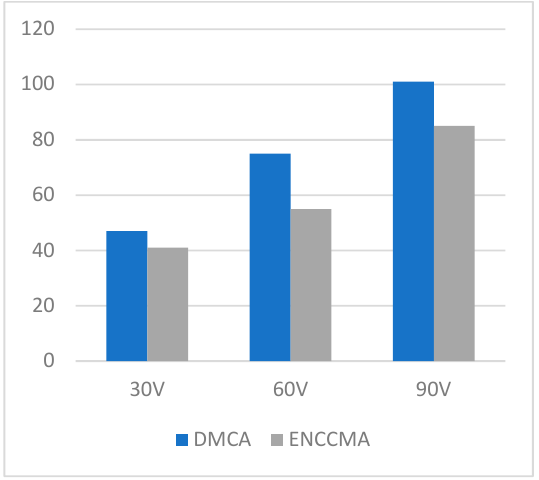
Figure 7. Data transmission for the highway environment.